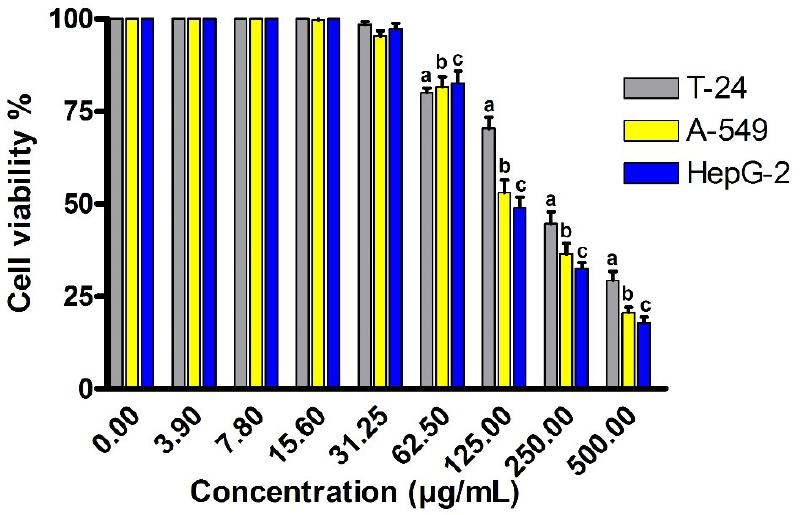
Figure 10. Evaluation of the cytotoxic activity of EPSR4 against different mammalian cancer cell lines; bladder carcinoma T-24, lung cancer A-549 and hepatocellular carcinoma (Hep-G2). Data are presented as mean ± SD. a p < 0.05 versus concentration of 0 µ g/mL in bladder carcinoma T-24, b p < 0.05 versus concentration of 0 µ g/mL in lung cancer A-549, c p < 0.05 versus concentration of 0 µ g/mL in hepatocellular carcinoma (Hep-G2).